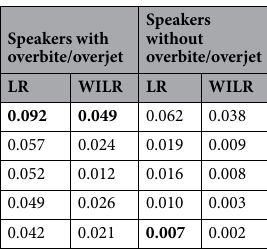
Table 4. LR and WILR values for ten speakers transcribed, ordered by bite type and LR values. Bolded figures are for the two speakers with the greatest perceived difference in bite type.